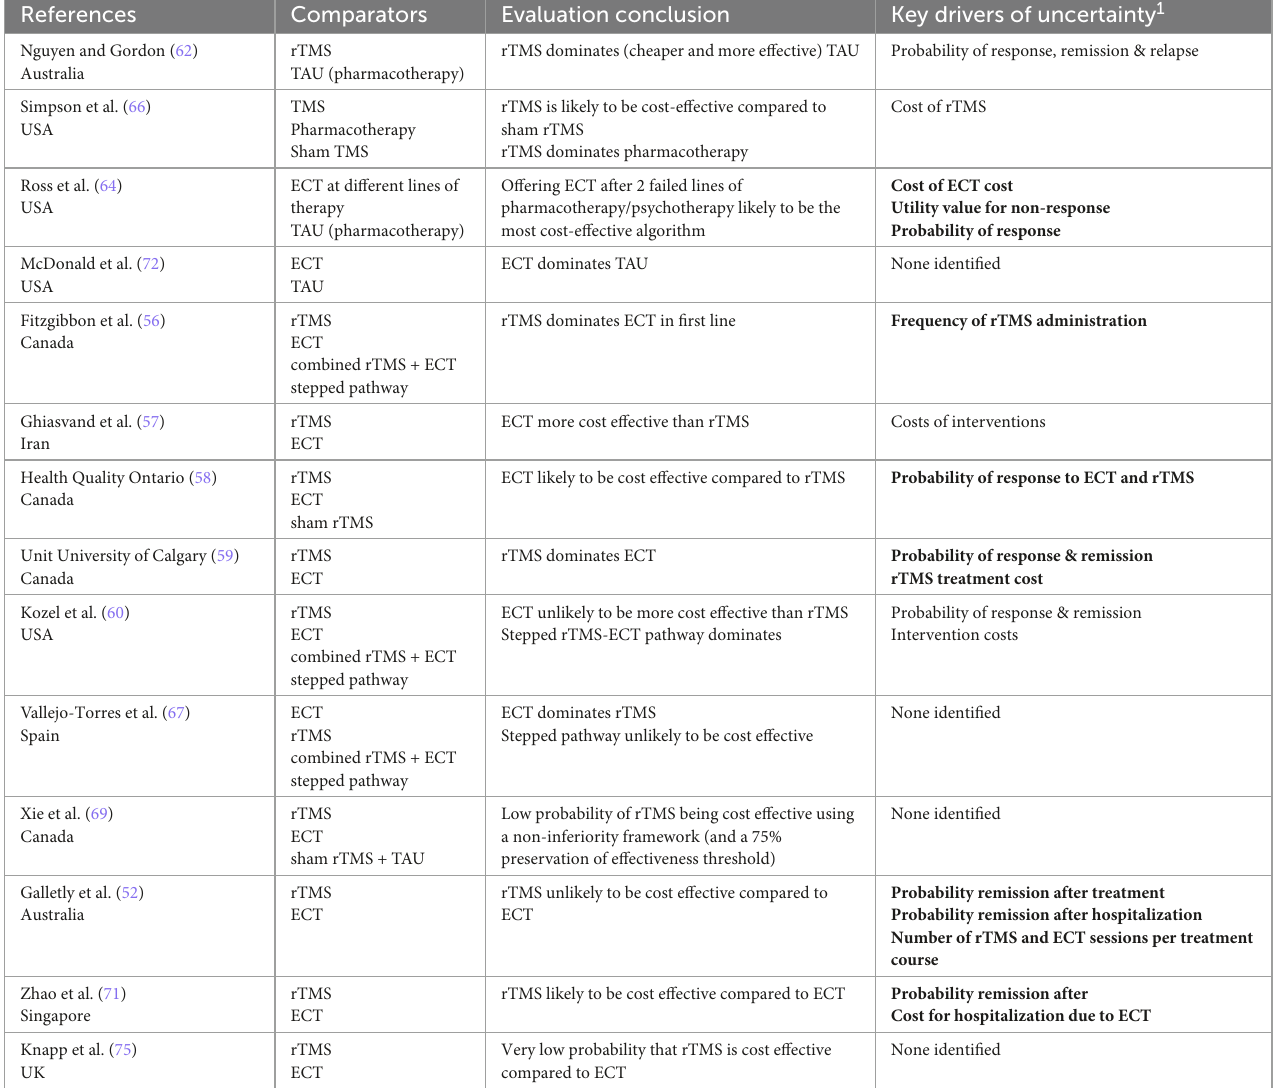
TABLE 4A Summary of authors’ conclusions, and key drivers of uncertainty for economic evaluations of non-pharmacological neuromodulation